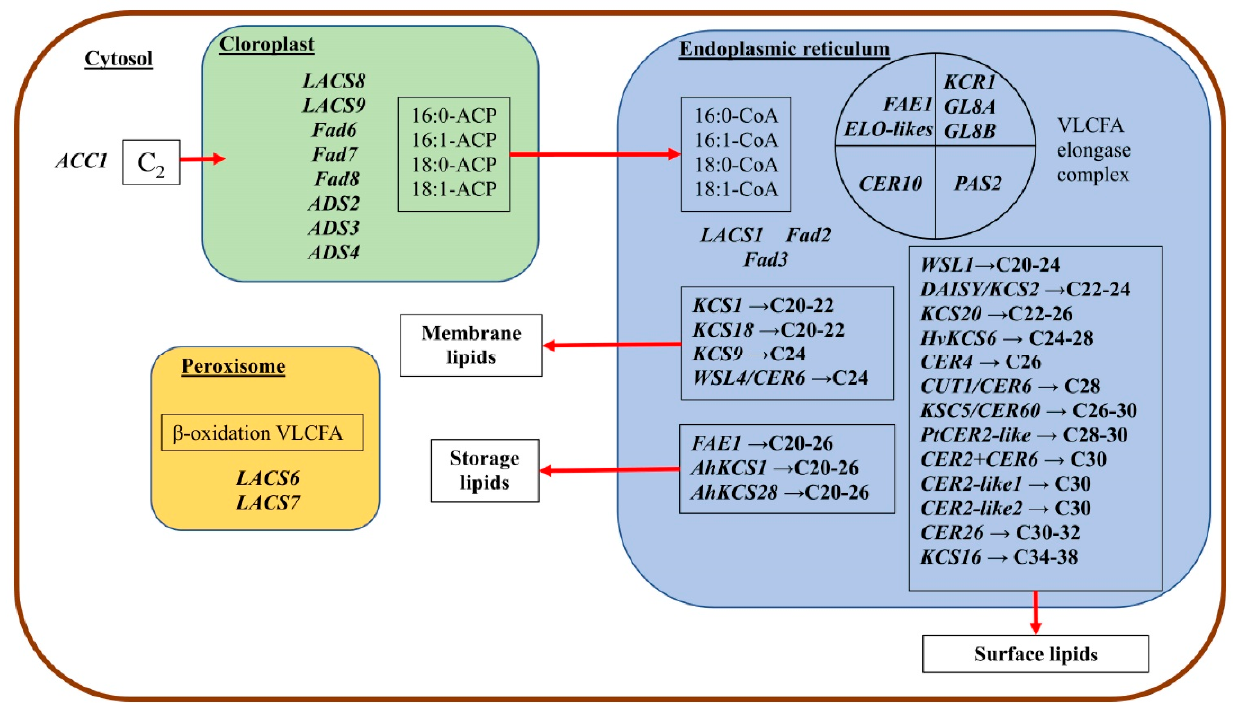
Figure 4. Genes encoding the elongation and desaturation enzymes involved in the synthesis of VLCFA and their derivatives. The ACC1 gene encodes cytosolic acetyl-CoA carboxylase, which synthesizes malonyl-CoA, used for the formation of regular-chain FA in chloroplasts and for the elongation of VLCFA in the endoplasmic reticulum (ER). Elongation of the VLCFA occurs with the help of the sequential operation of four enzymes of the elongase complex. Two gene families: FAE1 and ELO-likes encode β -ketoacyl-CoA synthase (KCS). The KCR1 , GL8A and GL8B genes encode β -ketoacyl-CoA reductase (KCR); PAS2 encodes β -hydroxyacyl-CoA dehydratase (HCD) and CER10 – enoyl-CoA reductase (ECR). For the synthesis of VLCFA of different lengths, which are included in the membrane, surface and storage lipids, some specific genes are needed. The Fad2 , Fad3 , Fad6 , Fad7 , Fad8 , ADS2 , ADS3 and ADS4 genes encode the desaturases localized in the ER and chloroplasts. The LACS gene family encodes numerous long-chain acyl-CoA synthases that are involved in several metabolic pathways, starting from FA activation, including the biosynthesis of PL, triacylglycerols (TAG), jasmonate and β -oxidation of VLCFA in